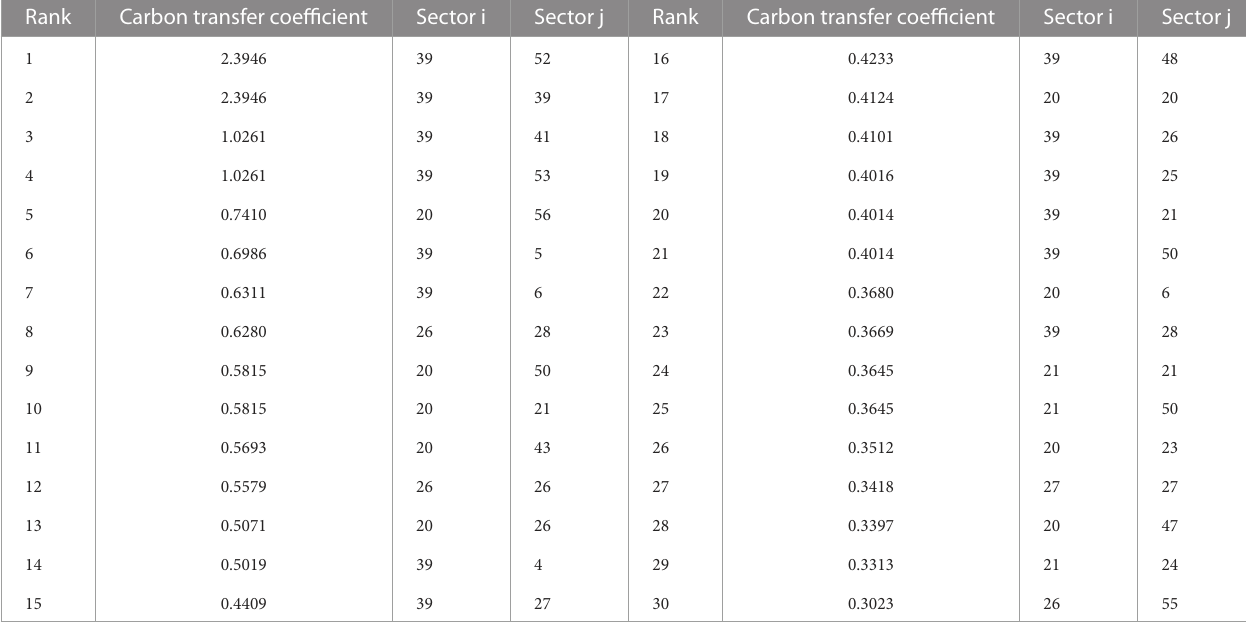
TABLE3 Top30carbonemissioncoefficientsamongallindustriesin2020.